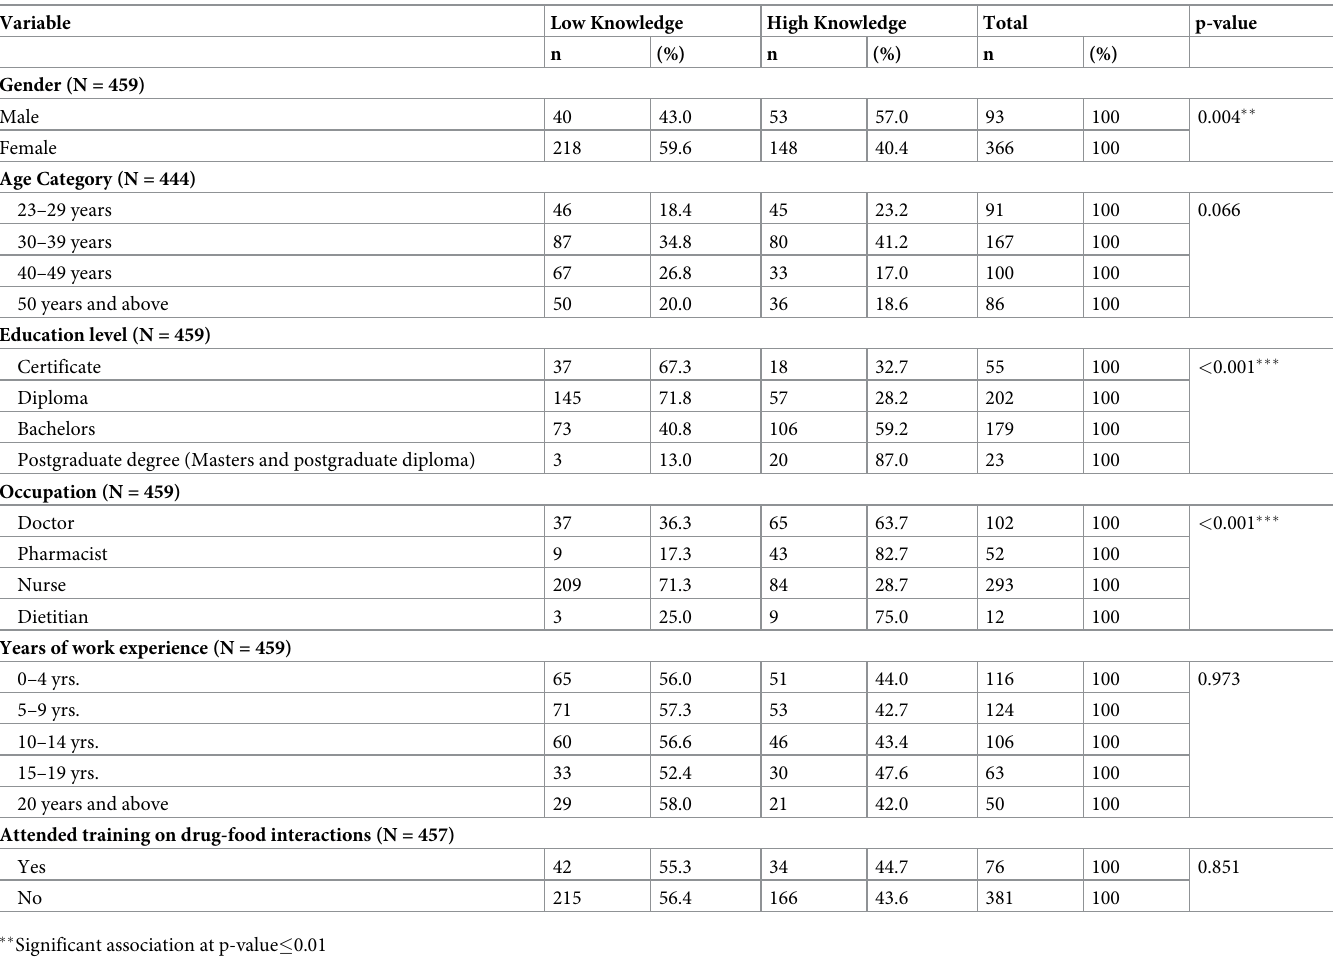
Table 3. Associations between demographic characteristics and the healthcare professional’s knowledge of drug-food interactions.